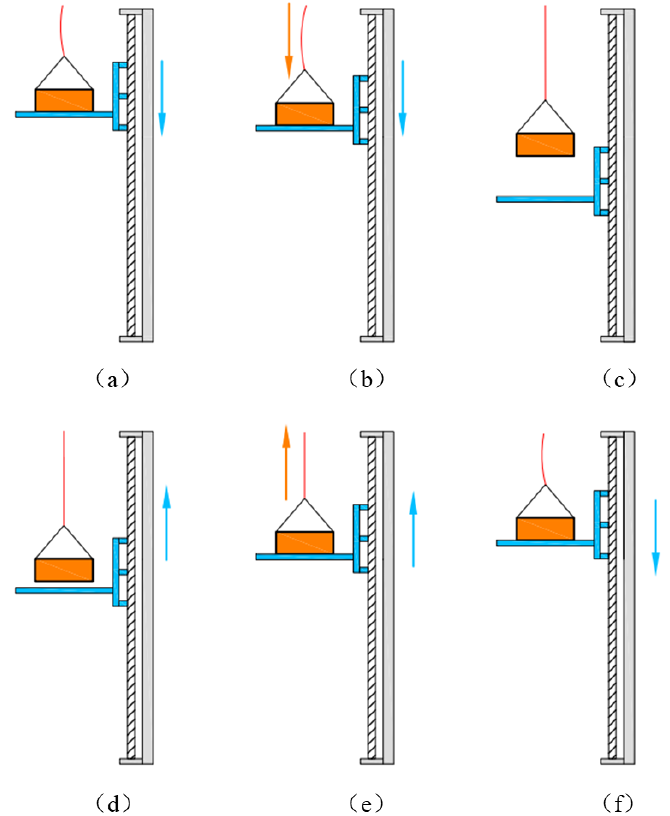
Figure 4. Loading stage: pallet in the highest position ( a ), moving down ( b ), reaching the lowest position ( c ), moving up ( d ), touching the load box ( e ), and back to the highest position ( f ).